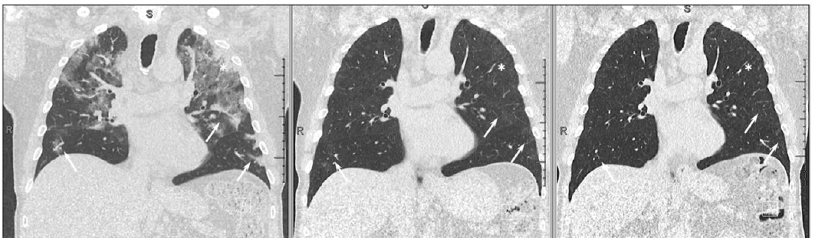
Fig. 2 Typical SARS-CoV-2 CT scan lesions and their evolution at 3 and 12 months. Asterisks show complete healing of the areas of consolidation at 3 months. White arrows demonstrate a slower but almost complete resolution of the areas of ground glass opacities at 3 and 12